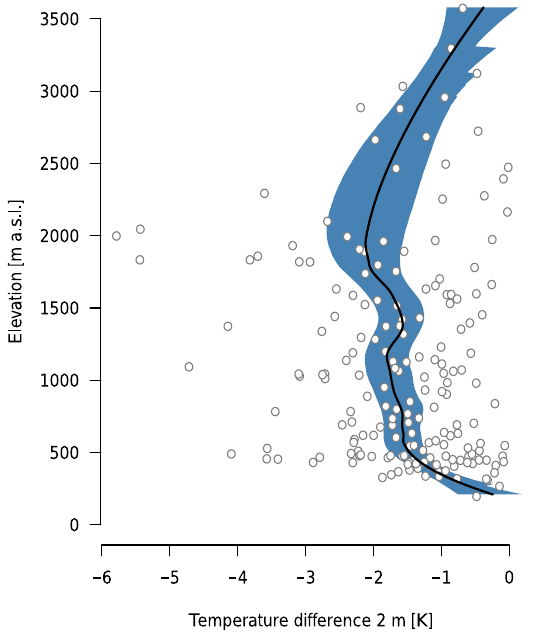
Figure 5. Temperature reduction maximum during the solar eclipse at 184 weather stations in Switzerland and Liechtenstein (open cir- cles) that record 10min averages. The elevation profile (bold line showing the moving mean over a 350m elevational window, equal to 10% of the entire elevation range) and its 95% confidence inter- val (blue band) were estimated using nonparametric bootstrapping.